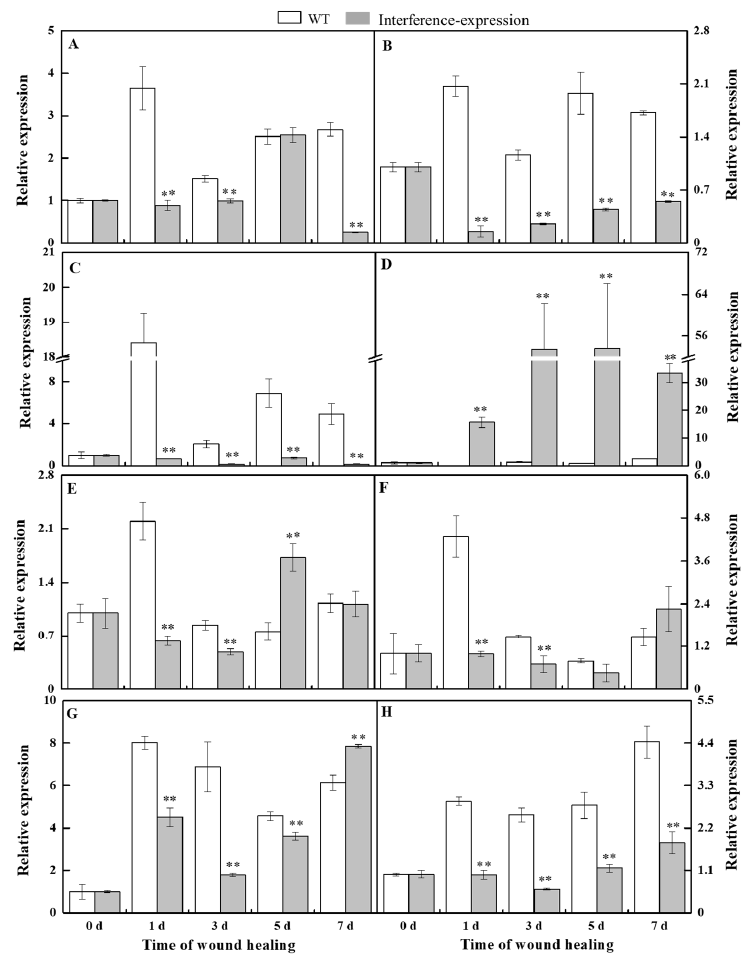
Figure 2. The interference expression of StMSD downregulated the gene expression of most StSODs genes during healing (( A ): StCSD1 ; ( B ): StCSD2 ; ( C ): StCSD3 ; ( D ): StCCS ; ( E ): StFSD1 ; ( F ): StFSD2 ; ( G ): StFSD3 ; ( H ): StMSD ). The potato elongation factor 1-alpha 1 ( efla ) was used as an internal control to normalize the data. Bars indicate standard deviation ( ± SD). Asterisks represent significant differences ( ∗ p < 0.05; ∗∗ p < 0.01). Each column represents the mean of three replicates. The healing was carried out at ambient temperature (20–25 °C; RH 80–90%) in the dark. The four RNAi lines were used in the experiment.